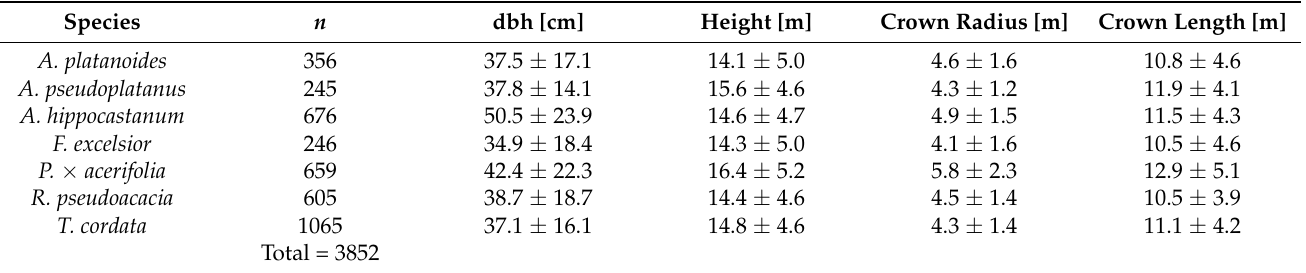
Table 1. Characteristics (means and standard deviation) of all measured trees. Abbreviations: n — number of samples, dbh— diameter at breast